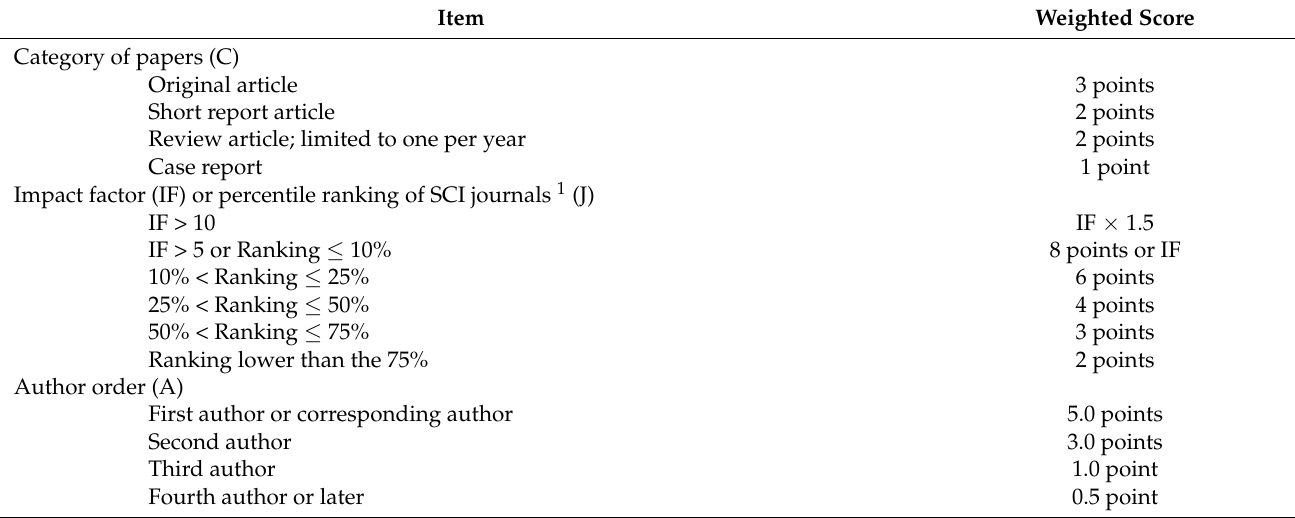
Table 2. Demonstration of the scoring system with examples from the medical school of National Yang Ming Chiao Tung